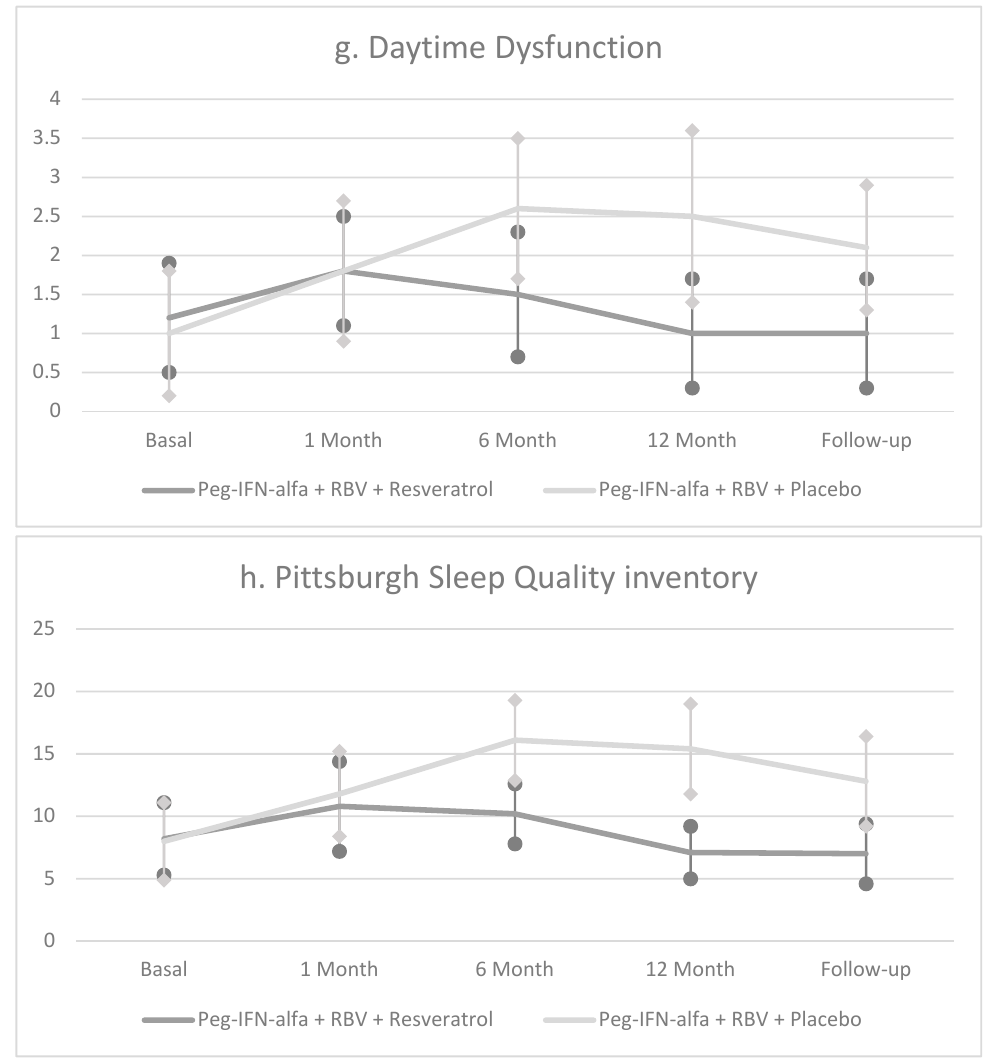
Figure 2. Representation of PSQI subfactors scores at baseline, and after 1, 6 and 12 months (mean ± SD) in HCV patients treated with Peg-IFN and Ribavirin with and without Resveratrol.